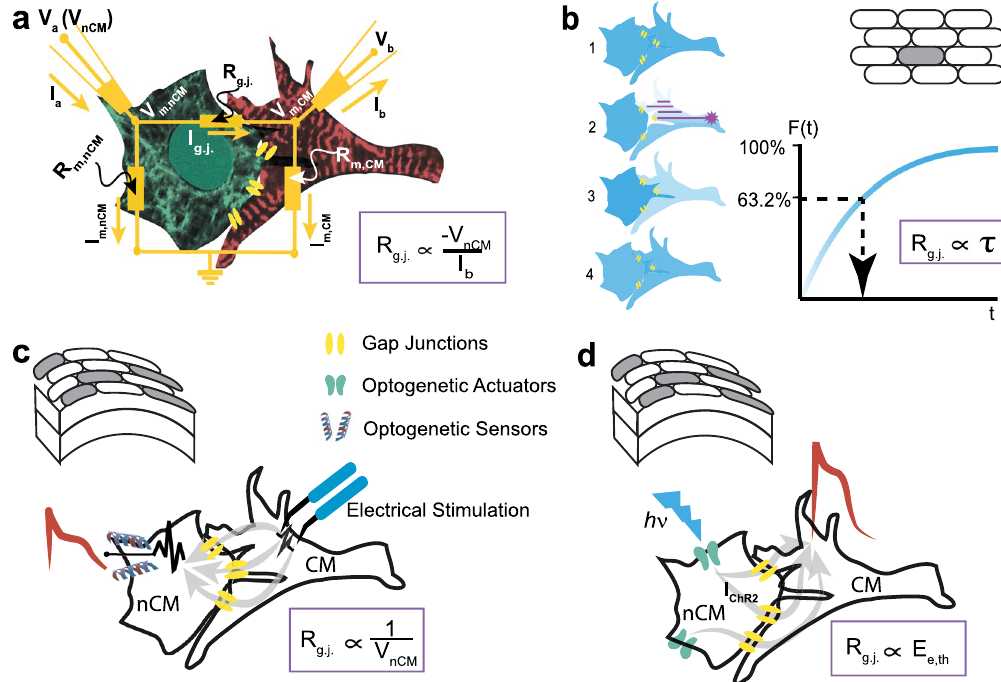
Figure 1. Existing and proposed methods for assessing electrical intercellular coupling. ( a ) Dual cell patch clamp measures the gap junction current based on equivalent circuits between two connected cells, a cardiomyocyte, CM (red) and a non-cardiomyocyte, nCM (green). After establishing an equilibrium (V a = V b = V m,CM = V m,nCM ) to eliminate junctional current, a voltage step is applied to one of the cell (e.g. V nCM ) prompting a compensatory junctional current that can be recorded. Specifically, V a acts as a stepping